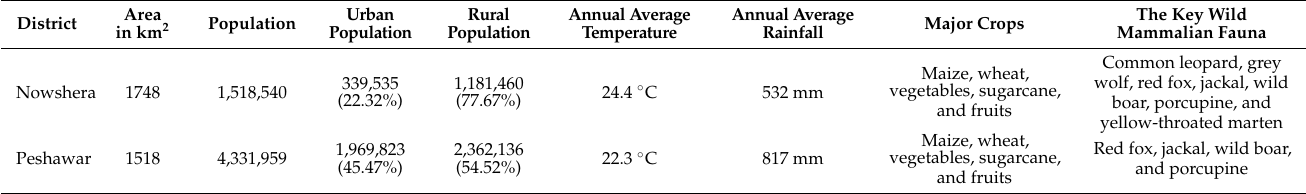
Table 1. Study area details with respect to geography, climate, and the human population, along with major crops and key wild mammalian